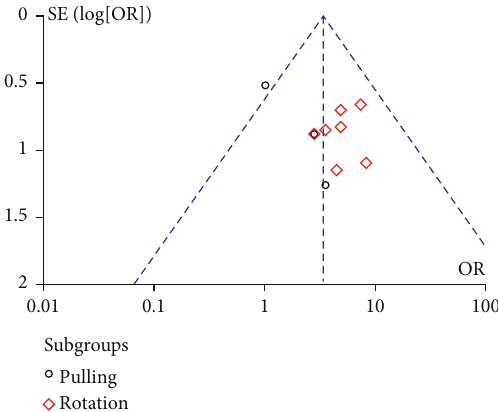
Figure 4: Funnel plots of short-term efficacy with 10 RCTs.